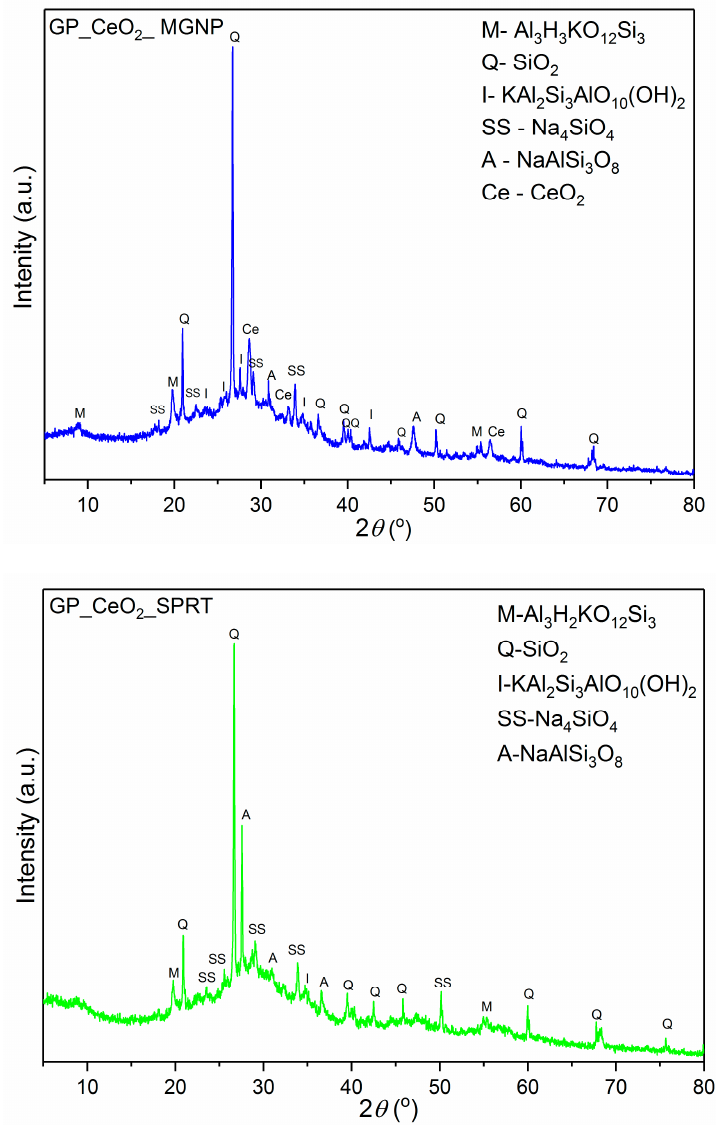
Figure 3. X-ray diffraction patterns of: ( a ) GP_CeO 2 _MGNP and ( b ) GP_CeO 2 _SPRT samples. Figure 3. X-ray di ff raction patterns of: ( a ) GP_CeO